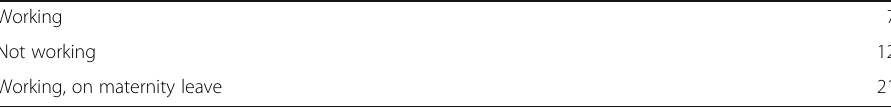
Table 7 Percent of unwanted births. Women in Belgium who had childbirth between January 1, 1968, and December 31, 1970 Working Not working